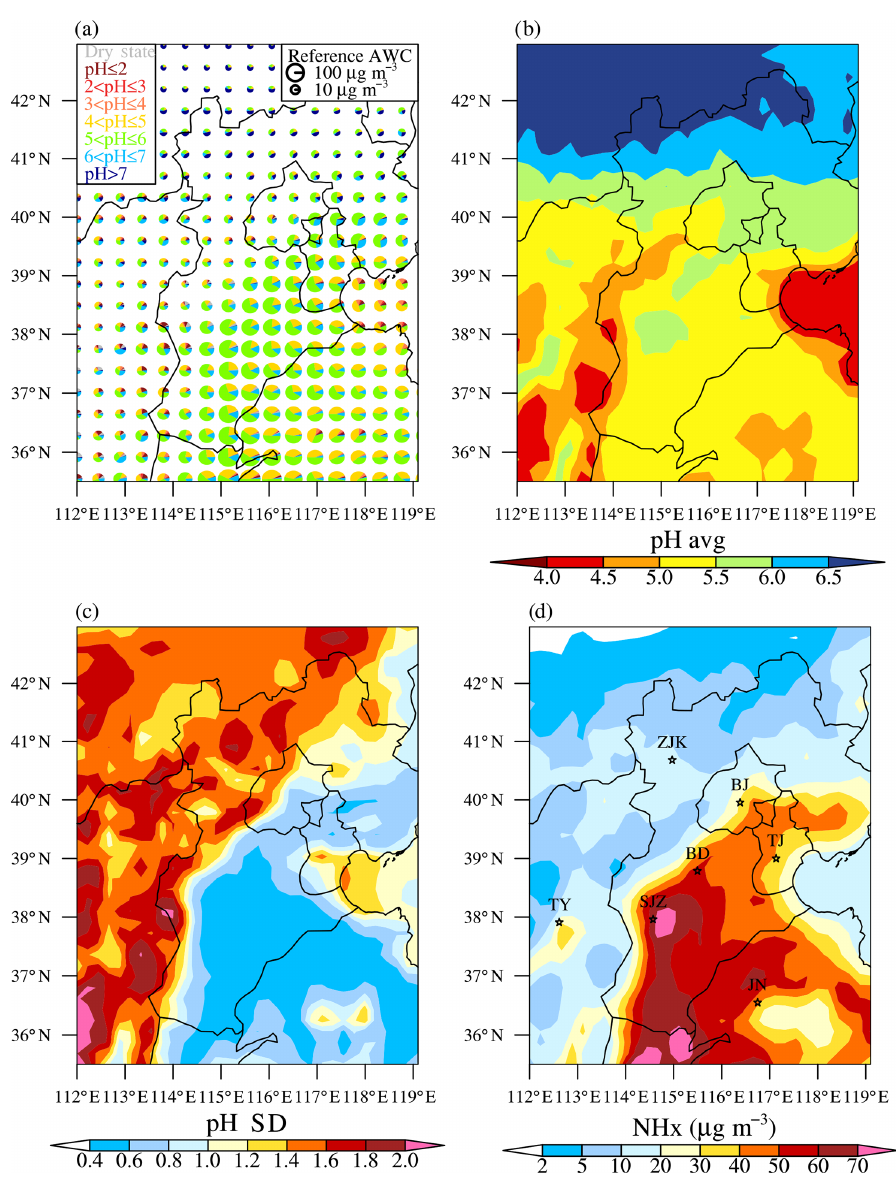
Figure 5. Fine particle pH and NH x concentrations at the surface layer simulated in the CTRL scenario during January 2013. (a) The frequencies for different pH ranges. The radius R for the pie chart is scaled using R/R ref = 2exp ( log10 ( AWC / AWC ref )) , and the reference radius R ref and aerosol liquid water content (AWC ref ) are also shown. (b) The horizontal distribution of the average, (c) standard deviation for pH, and (d) the concentrations of NH x . The locations for the seven cities of Beijing (BJ), Tianjin (TJ), Zhangjiakou (ZJK), Baoding (BD), Shijiazhuang (SJZ), Taiyuan (TY), and Jinan (JN) are also